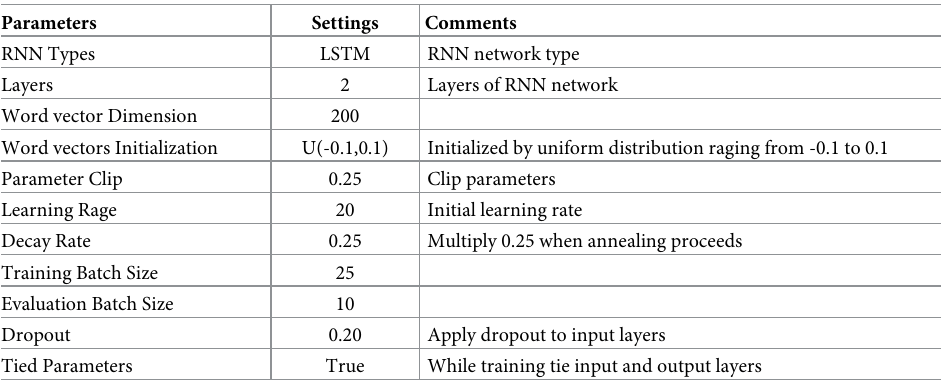
Table 2. The parameter settings of the benchmark